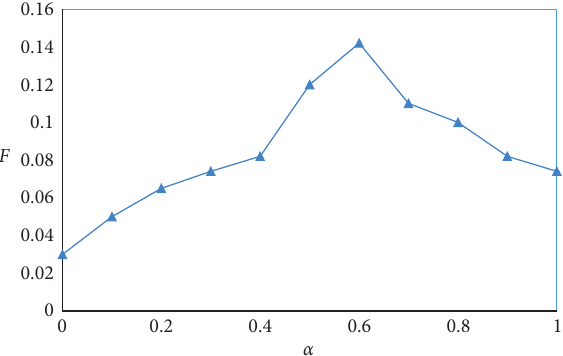
Figure 2: Parameter α evaluation of the recommendation